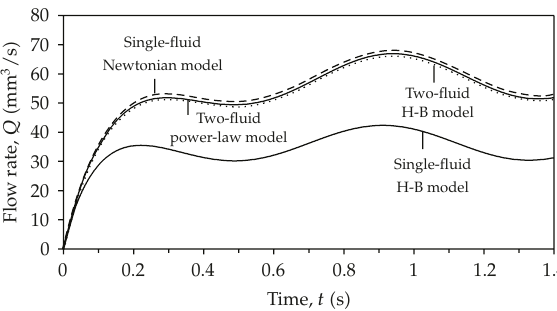
Figure 6: Variation of flow rate with time at the middle of the stenosis for di ff erent fluid models with α (cid:7) 0.95, φ (cid:7) 0.1 ◦ , τ m (cid:7) 0.1 a , μ H (cid:7) 0.035, and μ N (cid:7) 0.3 μ H .